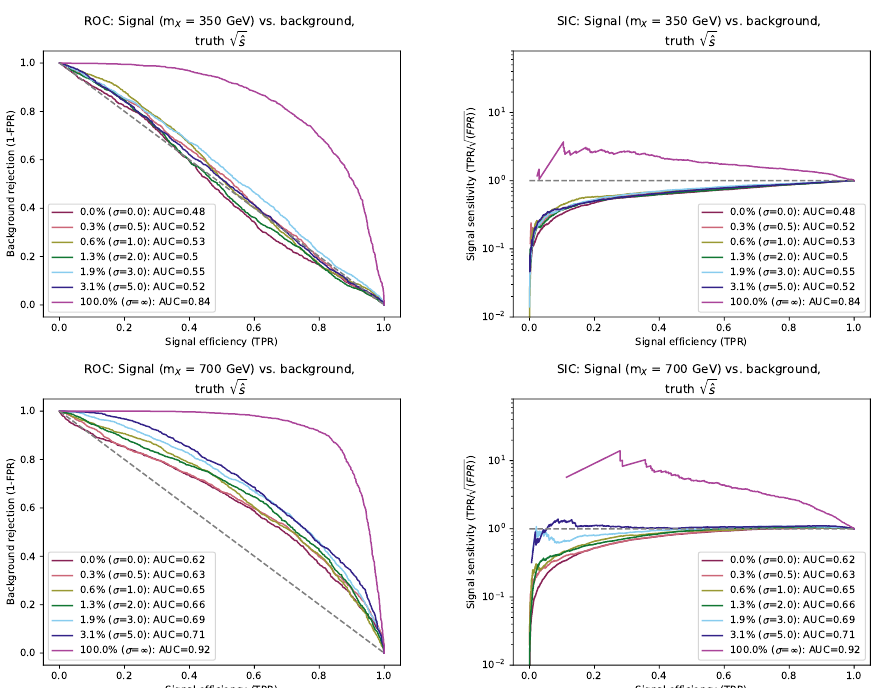
Figure 7. Weakly supervised training results using event-level input variables, in the form of ROC (left) and SIC (right) curves for m = 350 GeV (top) and m = 700 GeV (bottom). The dashed X X grey line indicates no improvement from the use of the neural network score. A significance of ∞ indicates the case of pure signal versus pure